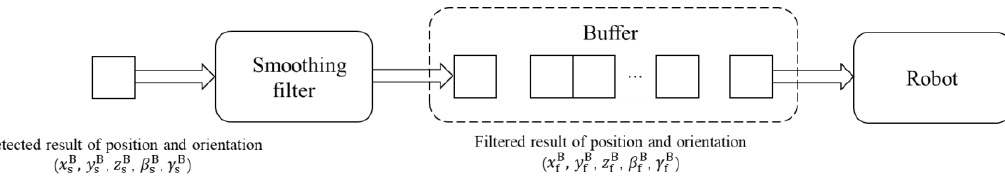
Figure 17. Dimension and orientation of the curved workpieces.